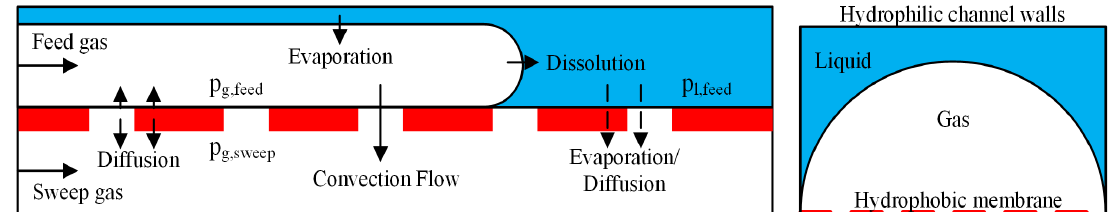
Figure 2. Cross and longitudinal section of the separation process.